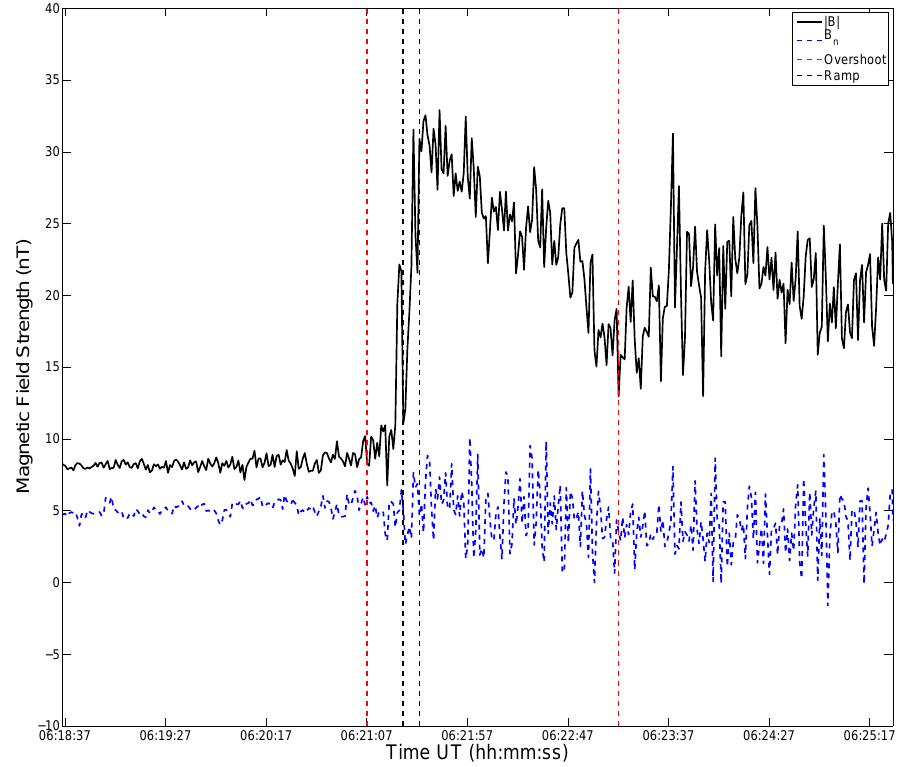
Fig. 2. A crossing of the Venusian bow shock on 11 June 2007. The black line shows the magnetic field profile measured by the VEX MAG instrument. The blue plot shows the magnetic field directed along the shock normal. Two red dashed lines show the interval of the magnetic overshoot used to determine the shock spatial